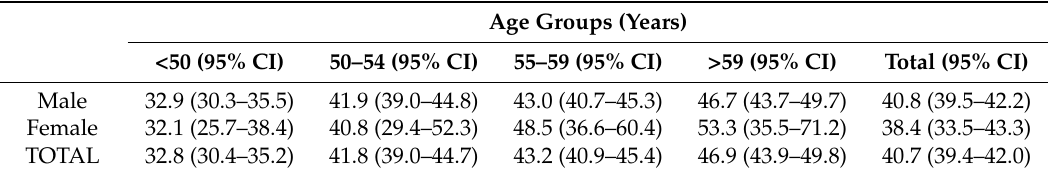
Table 1. Rate of dispensation of non-steroidal anti-inflammatories stratificated for age and sex in the cohort of workers in